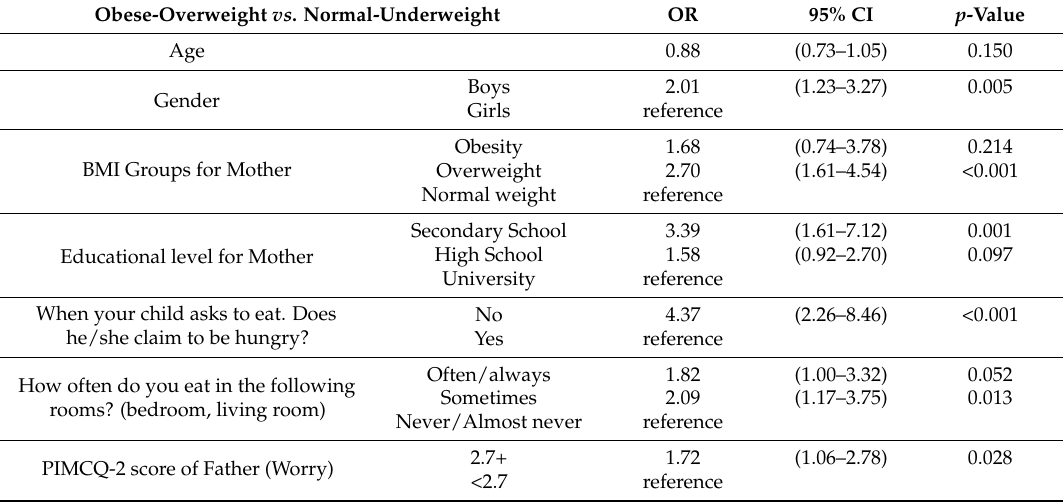
Table 4. Predictors of overweight-obese adolescents and their parents in multivariate